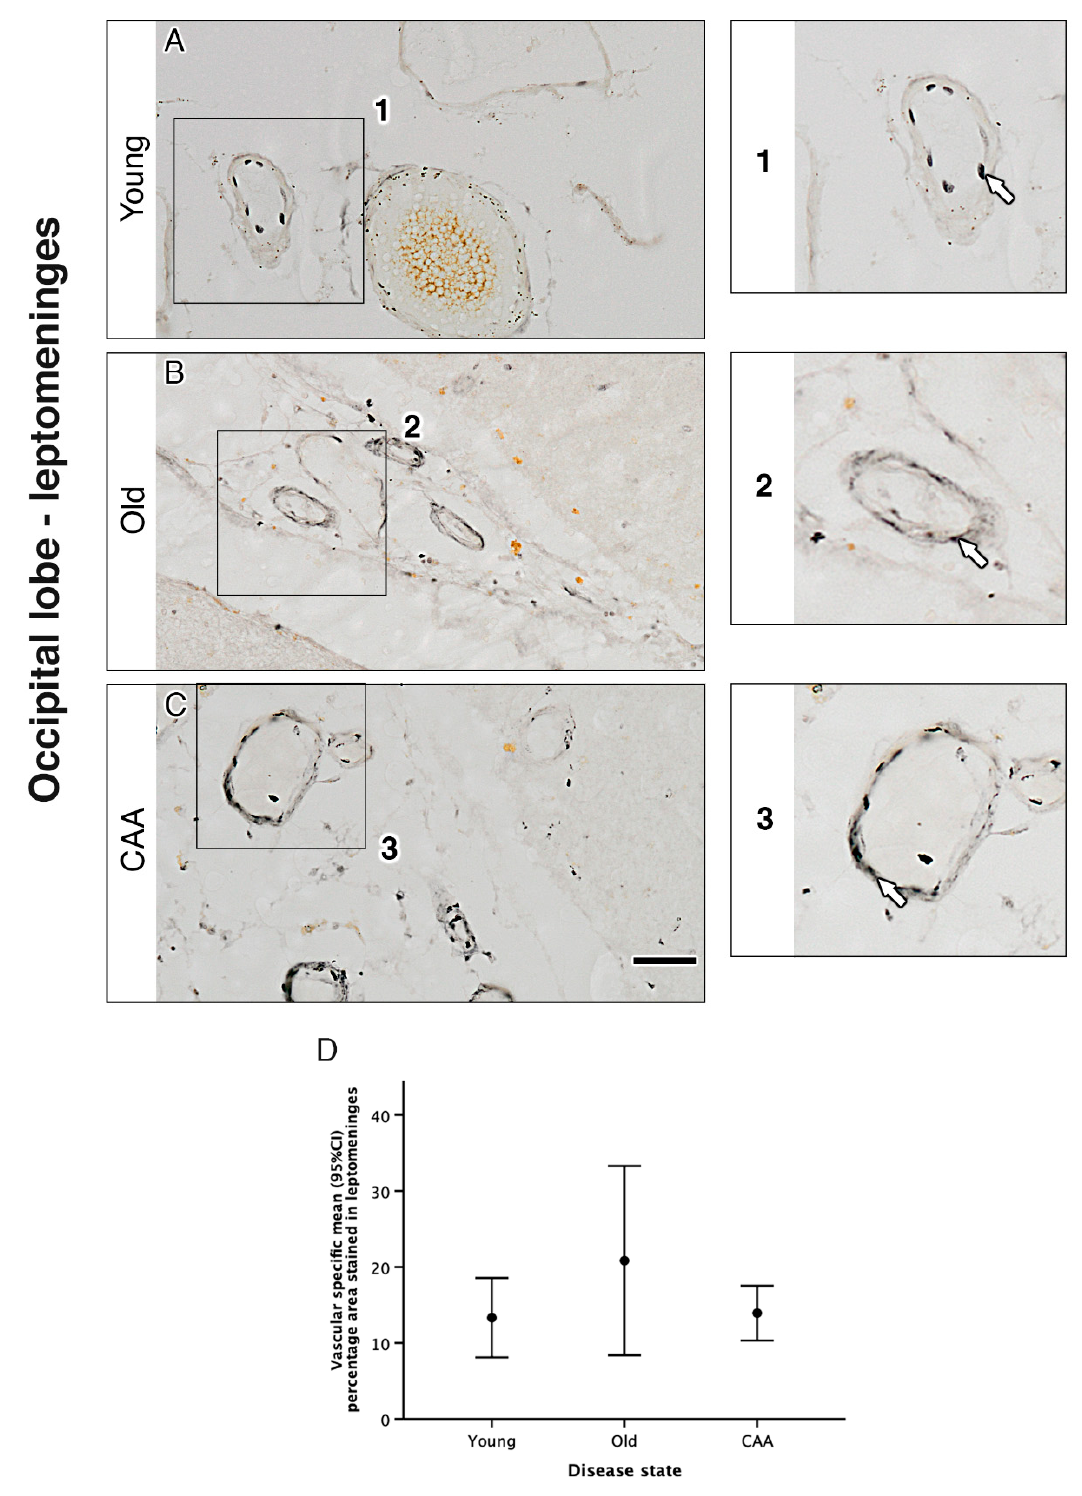
Figure 3. The pattern of distribution of the α 1A -AR in leptomeningeal vessels of the occipital lobe. In all cases, α 1A -AR immunoreactivity was observed in vessel walls ( A , B and C and enlarged boxes 1, 2 and 3). There were no significant differences in the percentage of the vessel wall positive for α 1A -AR between cases ( D ). Graph depicts the mean ± 95% confidence intervals, n = 5. Scale bar 50 µm.